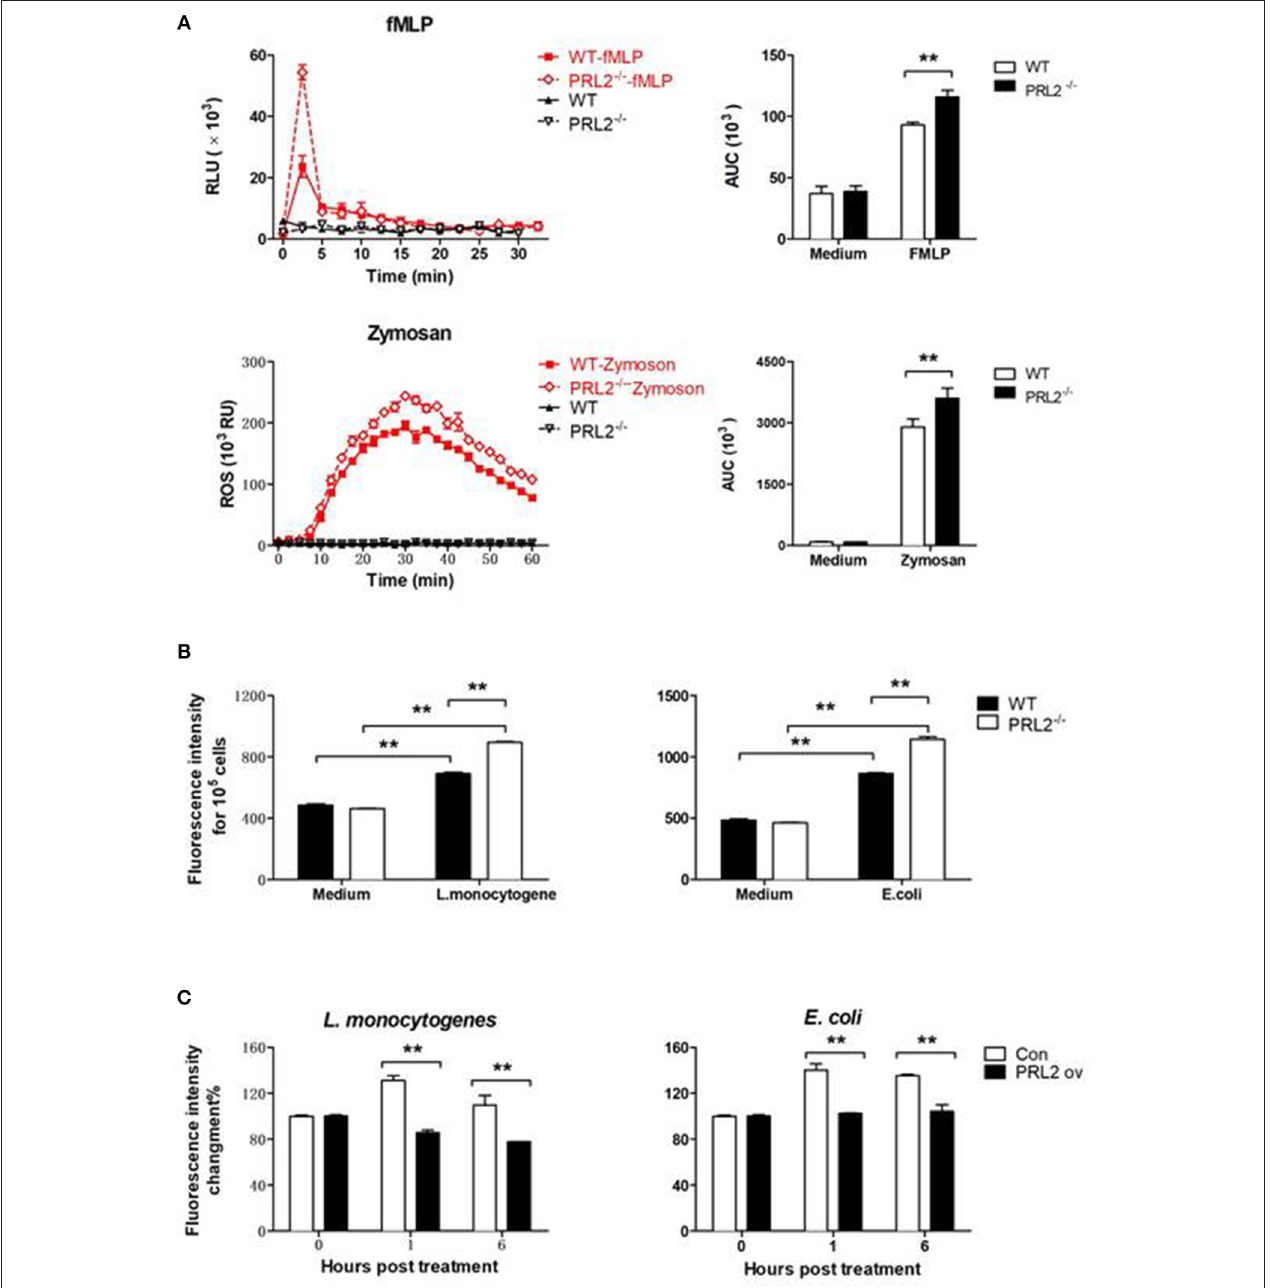
FIGURE 5 | PRL2 controls oxidative burst. (A) Neutrophils collected from PRL2 CKO mice and wild-type littermates were stimulated with 5 µ M fMlP or 100 µ g/ml Zymosan and ROS production was measured by chemiluminiscence assay as described in section Materials and Methods. Left, ROS kinetic plots of a representative experiment. Right, averaged area under cure (AUC) from 3 independent experiments. (B) WT and PRL2 − / − BMDMs were treated with bacteria as indicated in graph for 30min and ROS production was measured by fluorescent staining. (C) Raw264.7 cells were transfected with PRK5 or Myc-PRL2 PRK5 for 24h. Cells were treated with L. monocytogenes or E. coli at MOI = 10 (bacteria vs. cells) for 30min. ROS production was measured by fluorescent staining assay as above. Results shown are means ± SEM and are representative of more than three independent experiments. ** p <